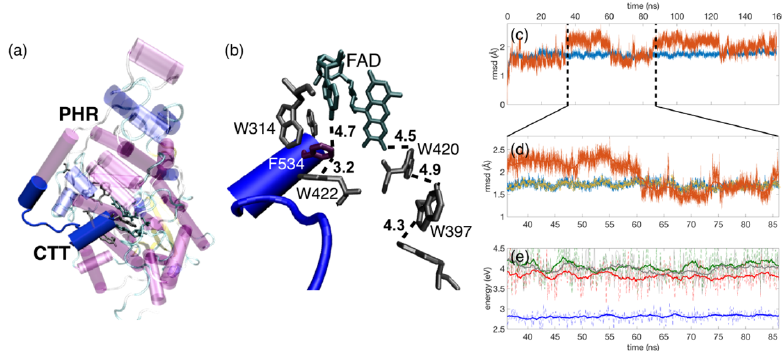
Fig. 1. (a) Structure of dCRY with helical C-terminal tail (CTT) highlighted in blue [3,4]; (b) Spatial arrangement of FAD cofactor and tryptophan residues, selected edge-to-edge distances in Å; (c) RMSD from a 160 ns trajectory of dCRY (blue) and CTT (orange, residues 515-537); (d) Zoom of CTT rmsd for the considered time interval in QM/MM simulations. (e) Excitation energies of the local excited ππ ∗ state of FAD (blue) and charge transfer states ISO − W420 + (red), ISO − ADE + (grey) and ISO − W314 + (green). Excitation energies were evaluated on QM/MM TD-DFT(BNL/cc-pvdz) level every 125 ps (dashed) and are shown together with the moving average